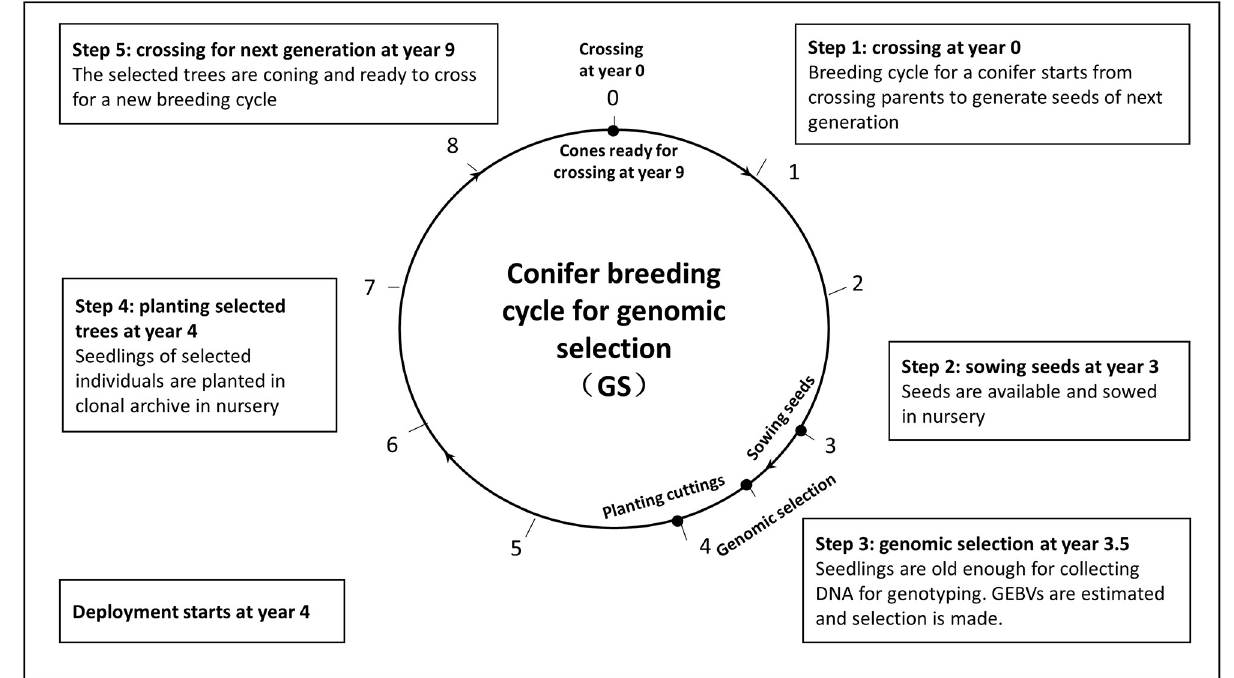
Fig 2. Example of conifer breeding cycle for genomic selection with a generation interval of 9